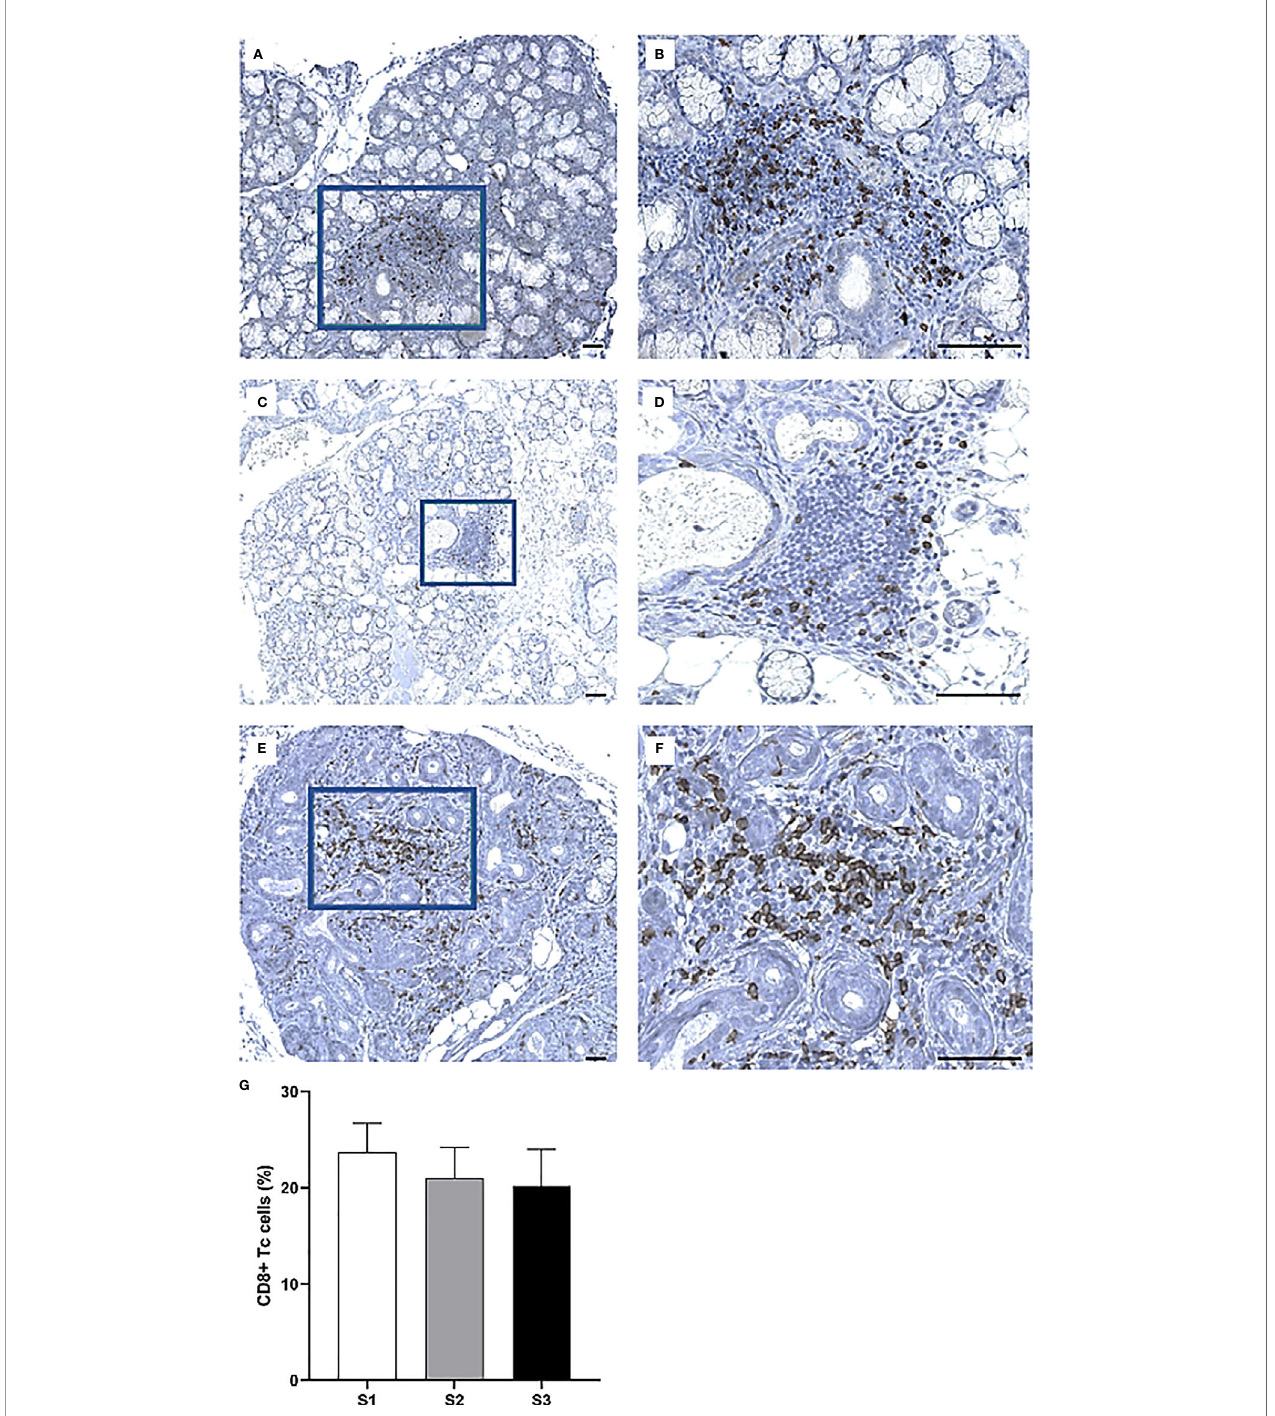
FIGURE 4 | Visualization of CD8 + Tc cells in the MSG of pSS patients. CD8 + cells were observed in both periductal foci and within the epithelial lining of salivary ducts, where such ducts mostly appeared to be non-dilated (A – F) . Interestingly, the incidence of CD8 + cells fl uctuated largely between patients regardless of lesion severity (G) . Immunohistochemical staining displaying the distribution of a speci fi c immune cell in three representative examples of focal in fi ltrates in the MSG as classi fi ed into the respective in fl ammatory severity stages; S1 (A, B) , S2 (C, D) , and S3 (E, F) . Image (B) is a magni fi cation of (A) , image (D) is a magni fi cation of (C) , image (F) is a magni fi cation of (E) . Scale bar = 0.5 mm. Bars (G) indicate the mean percentage of cell-type number/total in fi ltrating mononuclear cells in each stage and error bars represent ± SEM. The Student's T test was